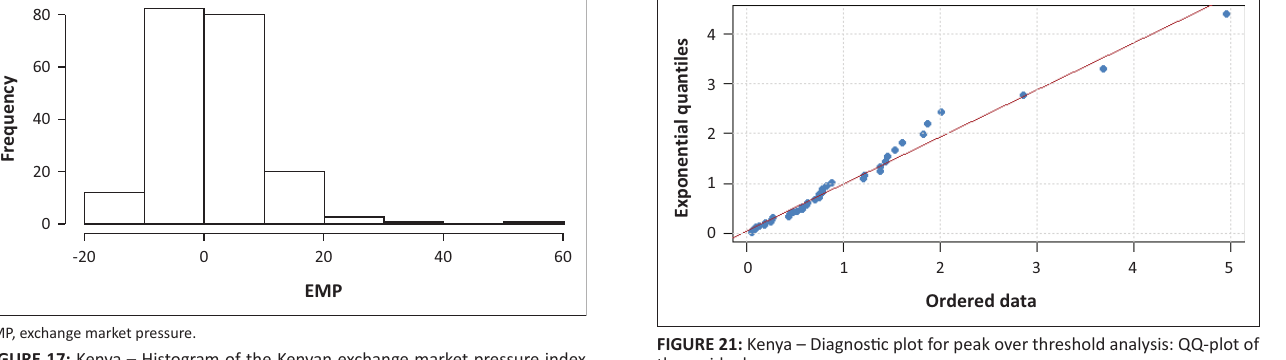
FIGURE 17: Kenya – Histogram of the Kenyan exchange market pressure index for 2000–2017.